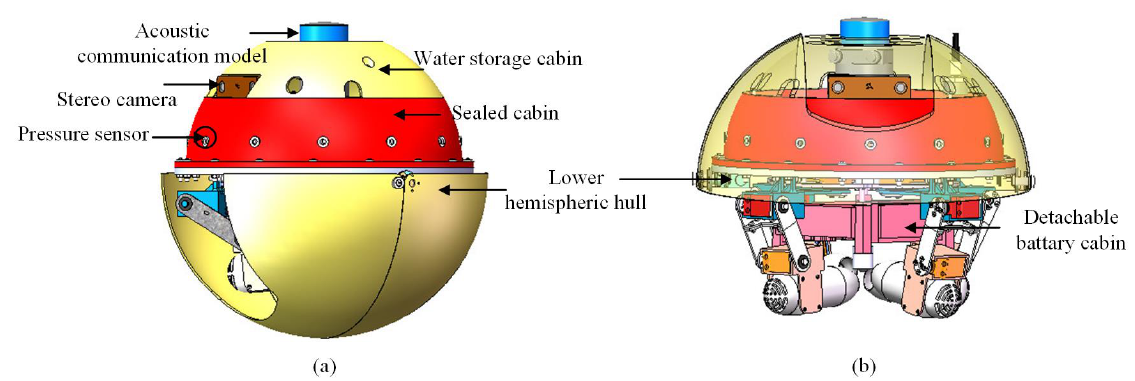
Figure 1. Prototype of the turtle-inspired amphibious spherical robot. ( a ) The two separate quarter spherical shells are closed. ( b ) The two separate quarter spherical shells are open.